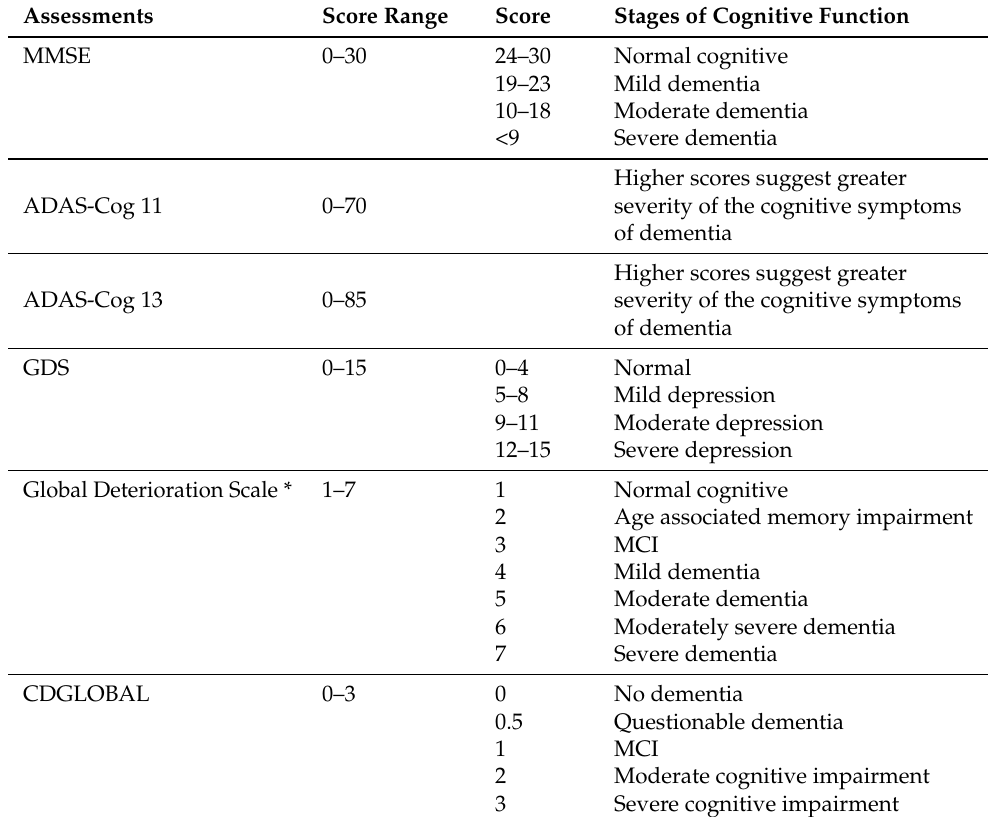
Table 1. Examples of clinical and neuropsychological assessments and laboratory analysis for the diagnosis of AD considered in this